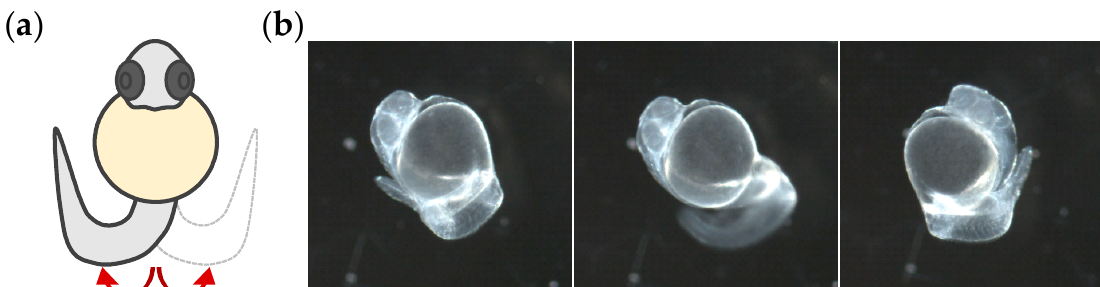
Figure 1. Tail coiling activity in zebrafish ( Danio rerio ) embryos. ( a ) Drawing of embryo showing the direction of alternating coils of the tail. ( b ) Dechorionated embryo at 26 h post-fertilization (hpf) exhibiting consecutive tail coiling. Left: tail coiling to the right side; middle: transient tail coiling; right: tail coiling to the left side. Removal of the chorion was performed for a better visualization, and this procedure was not conducted for embryos used in experiments. Amplification: 1.0 ×.